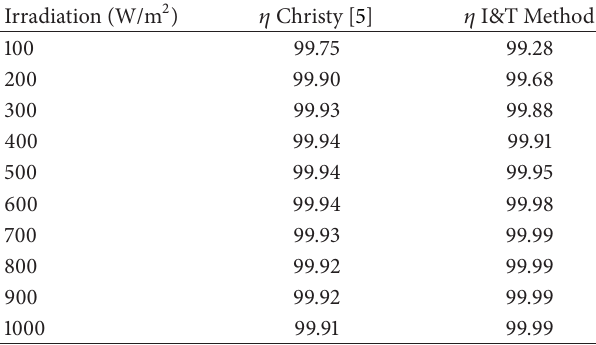
Table 2: Efficiency versus irradiation @ 45 ∘ C (cell temperature), adapted from